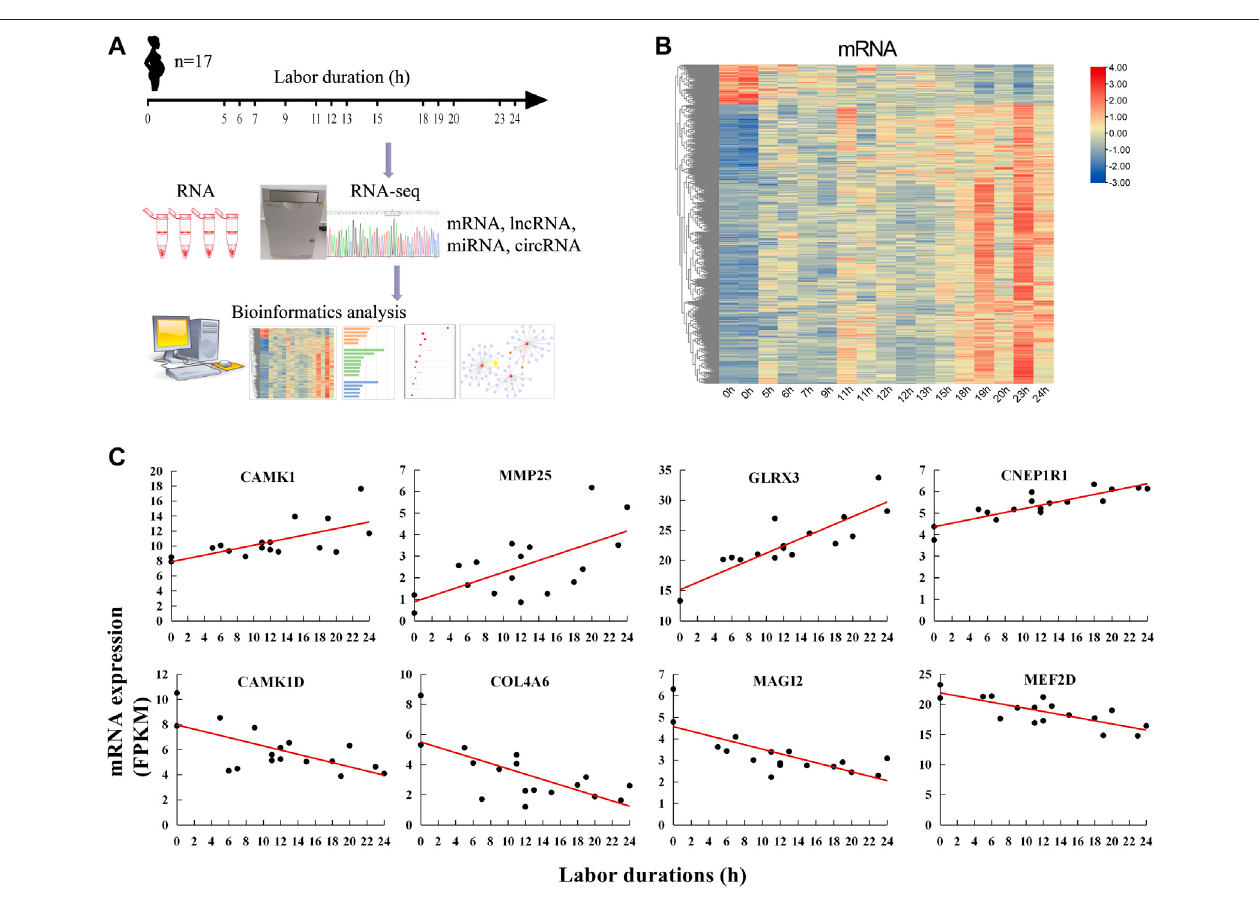
FIGURE 1 | Labor duration – correlated mRNAs expression. (A) Overall study design and work fl ow. (B) Heat map of expression of labor duration – correlated mRNAs. Data associated with this fi gure can be found in Supplementary Table S2 . (C) The expression trend of mRNAs at different labor durations.